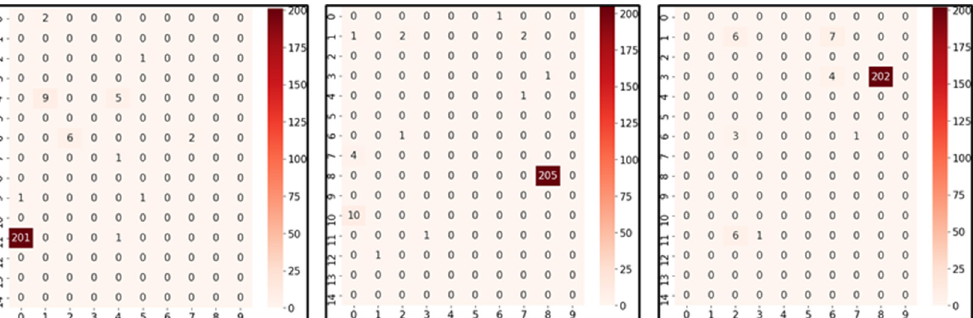
Sensors 2023 , 23 , 3453 13 of 16